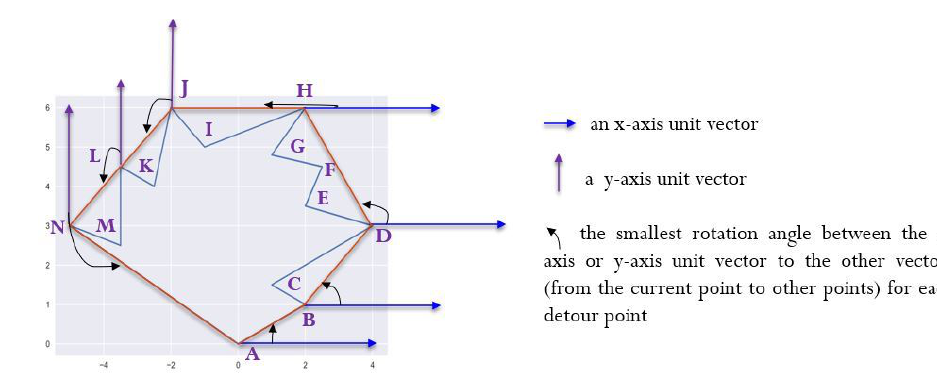
Figure 1. Graph representation for VRAOA algorithm.